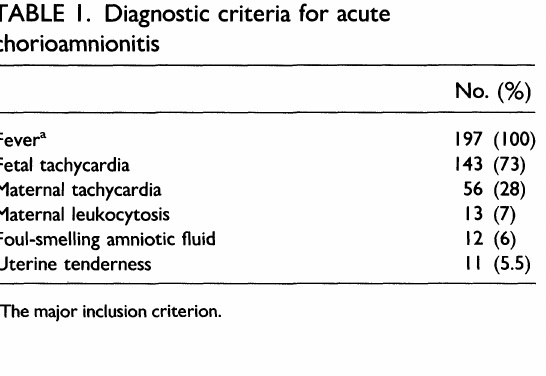
TABLE 2. FHR patterns and Ua pH determinations